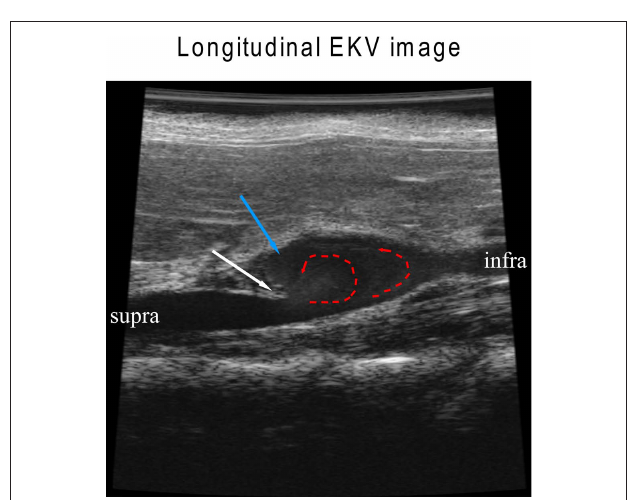
FIguRE 3 | Aortic dissection leads to flow pattern changes in an Ang II-induced AAA. White arrow indicates an aortic dissection “flap” where the elastic media has broken down; red dotted arrows show altered flow; blue arrow indicates a region with re-circulating slow flow where thrombosis/ coagulation may